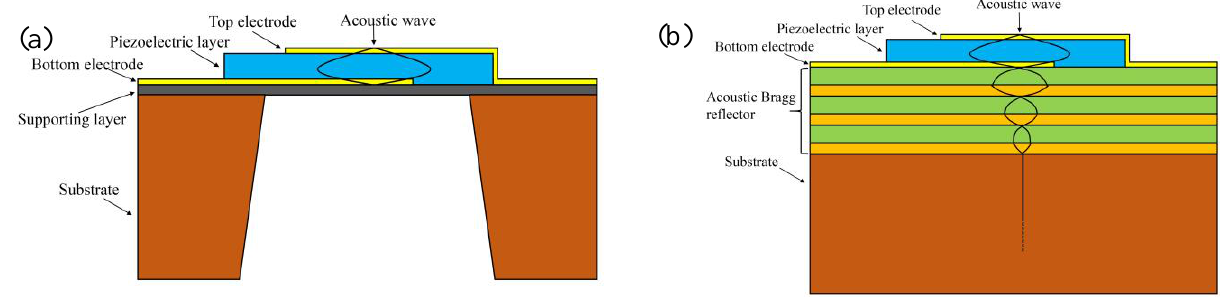
Figure 4. (a) Conventional FBAR structure; (b) SMR-type FBAR structure. 179 Figure 4. ( a ) Conventional FBAR structure; ( b ) SMR-type FBAR